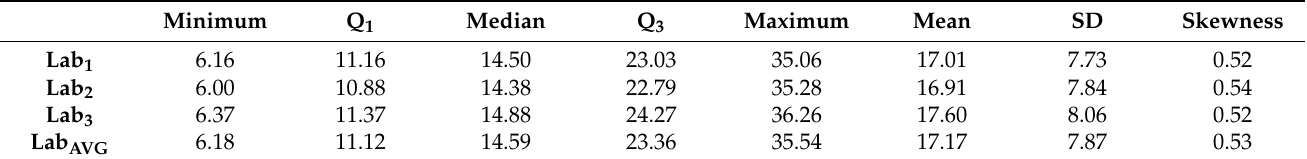
Table 2. Summary statistics of SOC measurements (g kg − 1 ) from three different laboratories